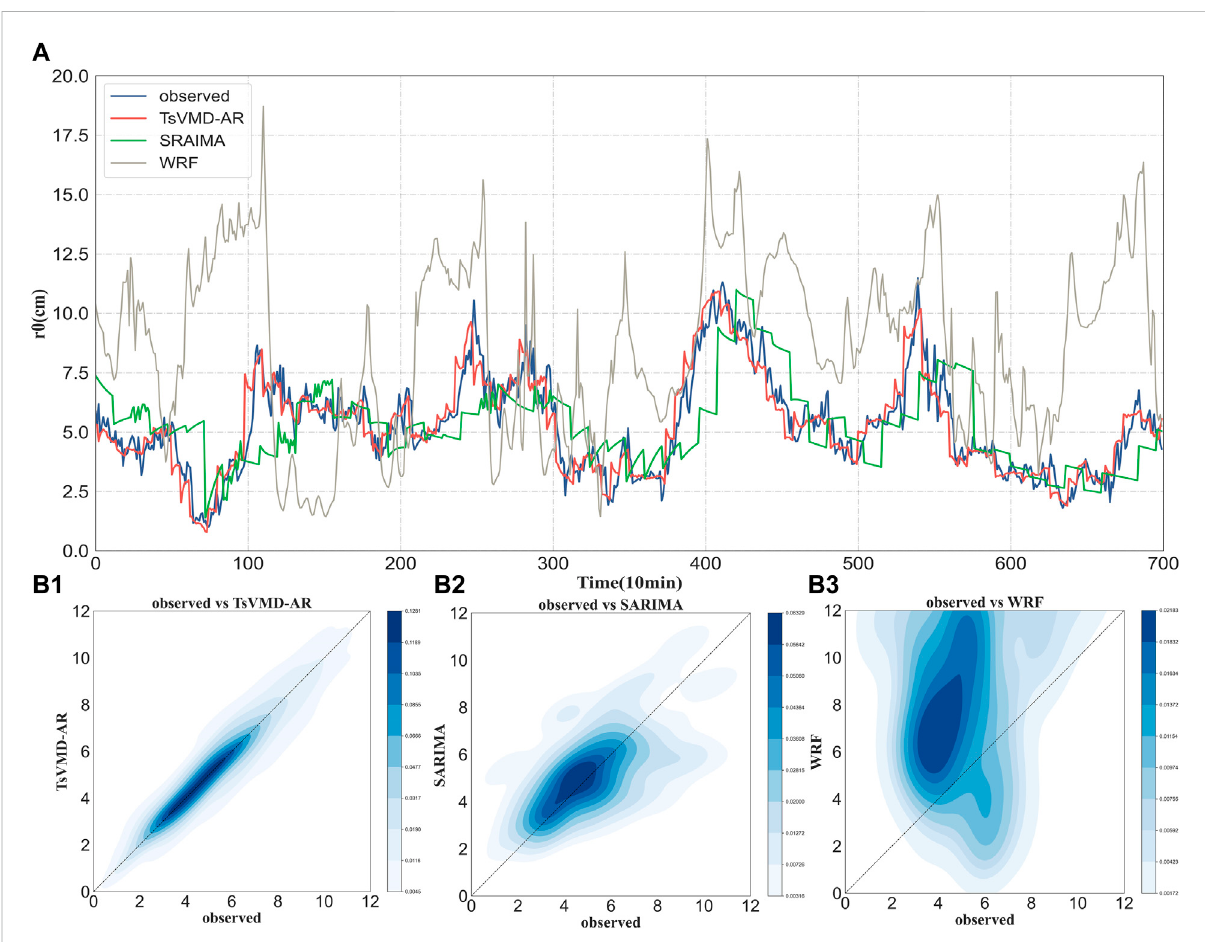
FIGURE 5 Forecasting results of the proposed method and the contrast method for period 2: (A) observed atmospheric turbulence (blue) and forecasting results of TsVMD-AR (red), SARIMA (green) and WRF (grey); 2D histograms of observed atmospheric turbulence verse forecasting results of TsVMD- AR (B1) , SARIMA (B2) and WRF (B3)